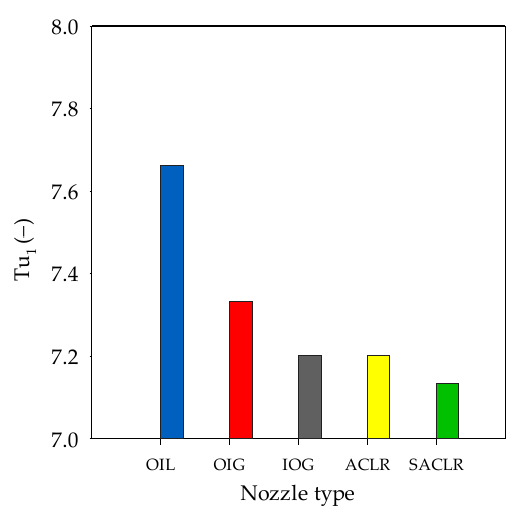
Figure 11. ( a ) Variation coefficient of gas void fraction and C D ; ( b ) slip ratio of the flow inside the exit orifice for the tested nozzles: at GLR = 1.2%, ∆p mix /p amb = 0.98, µ L /µ G = 55.